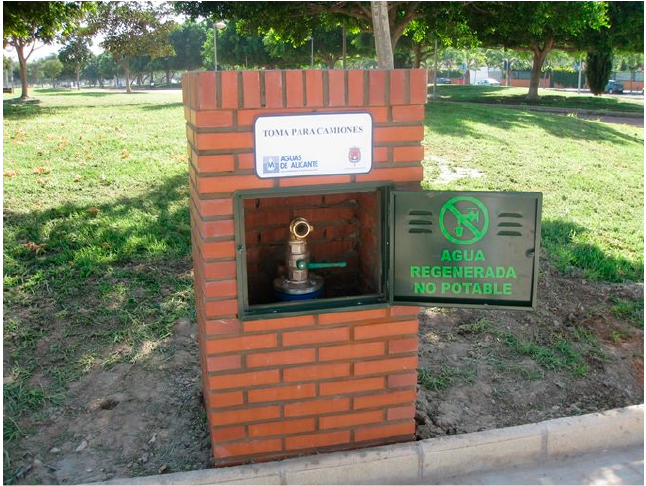
Figure 6. Treated water hydrant (city of Alicante, 2018) . Source: Picture by the authors.